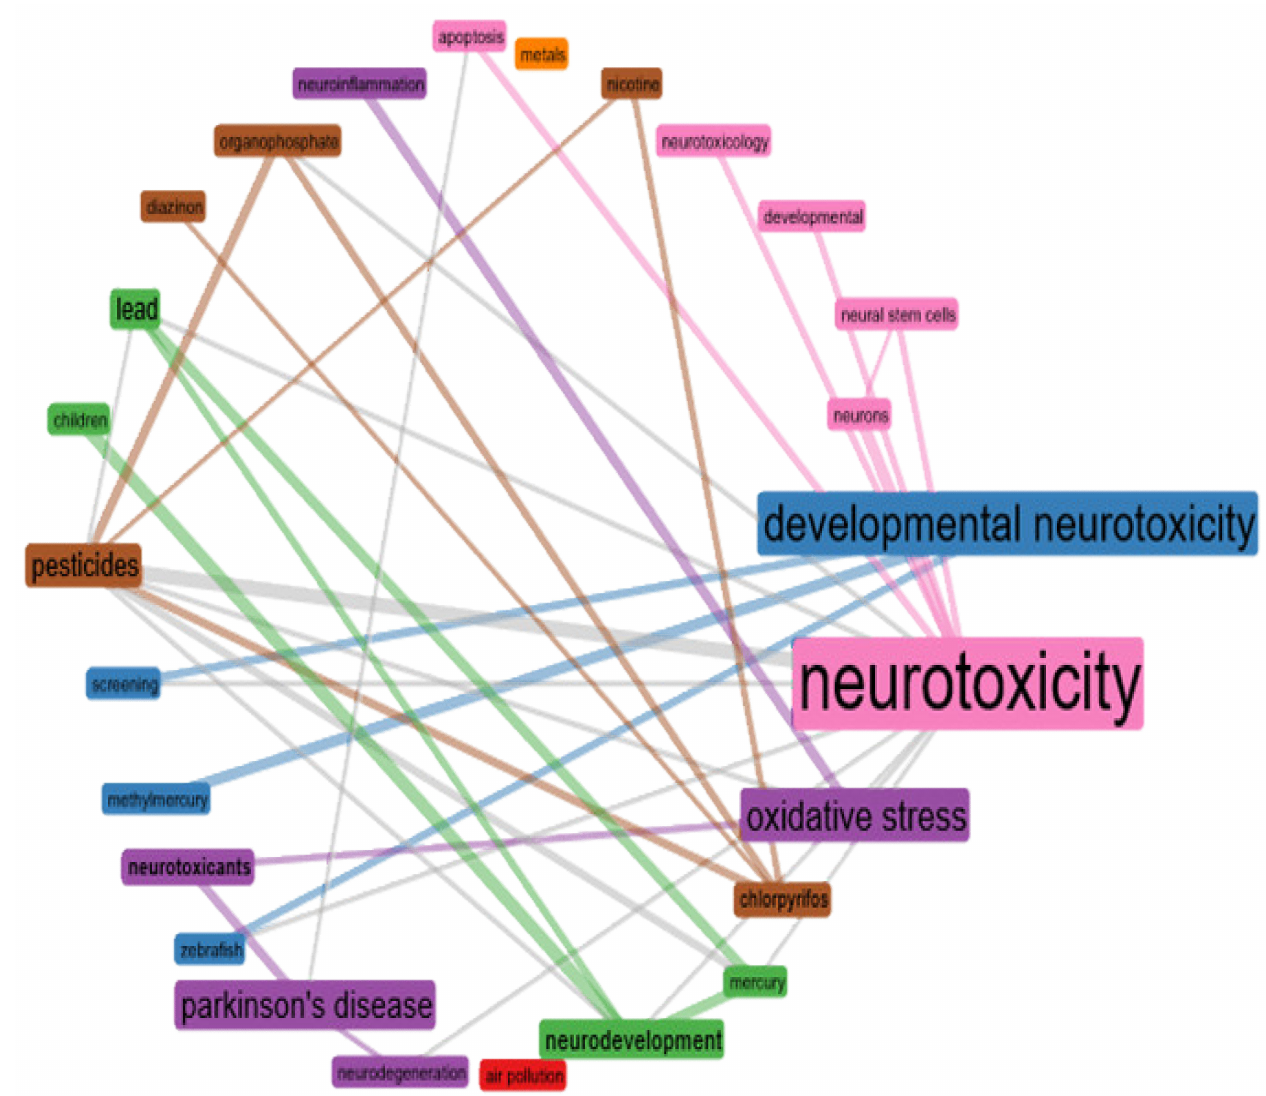
Figure 6. Top author’s keywords from 2011 to